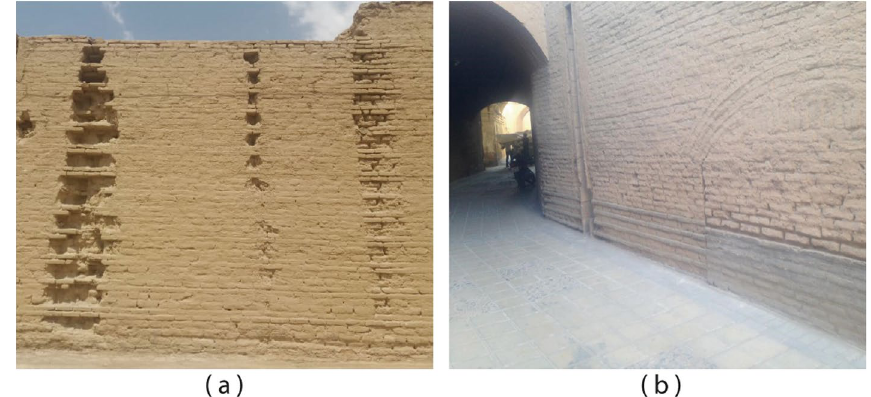
Fig. 10 Application of brick courses in adobe walls in the Yazd historic fabric: ( a ) along the wall height (Source: the authors) and ( b ) at the wall base (Source: Ehsan